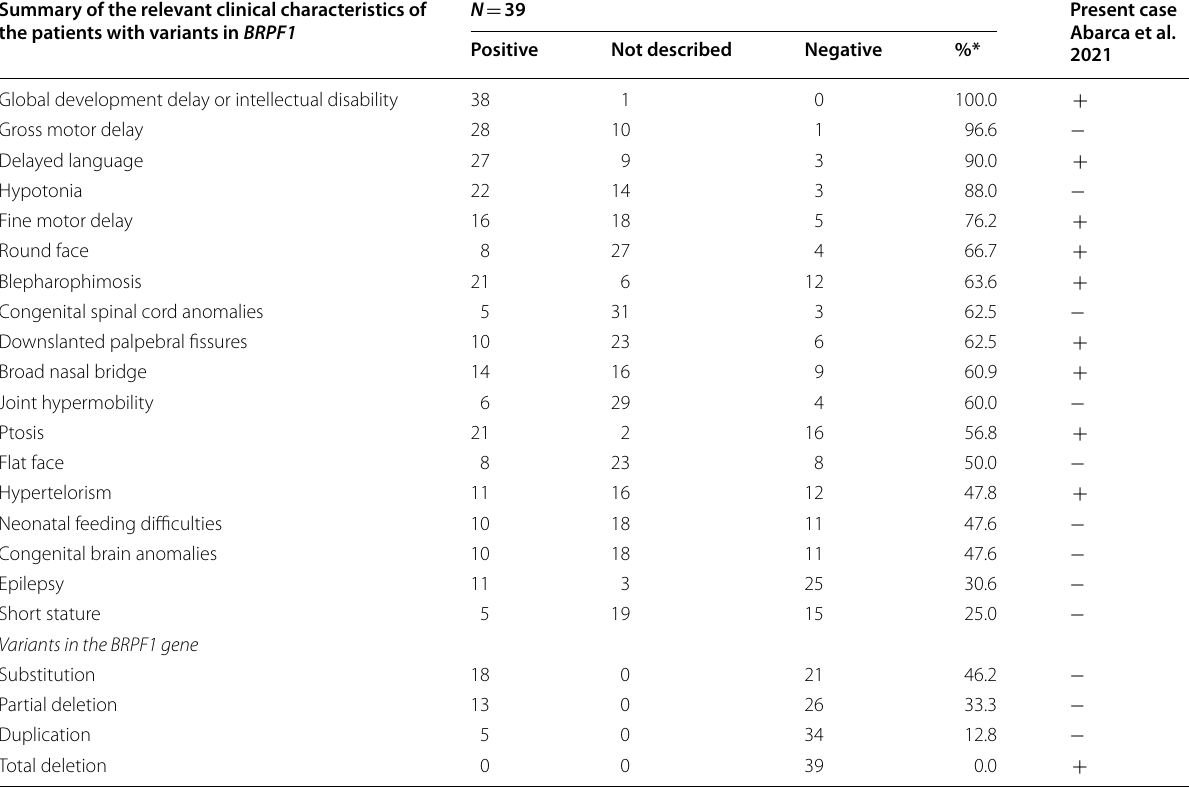
* Excluded to not described patients